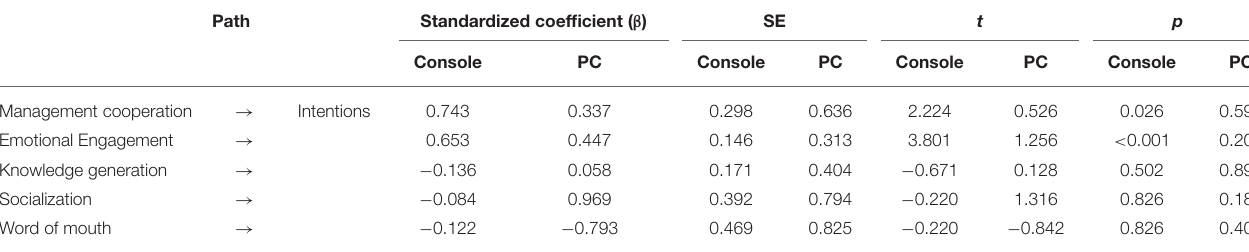
TABLE 6 | Multigroup analysis (MGA) results.